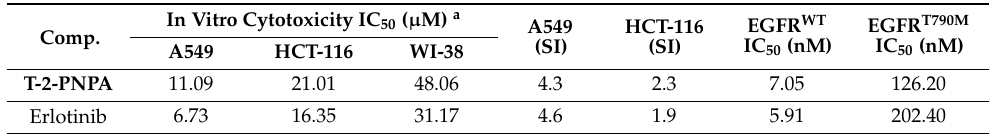
Table 5. In vitro anti-proliferative and safety assessment of T-2-PNPA against A549, HCT-116 and WI-38 cell